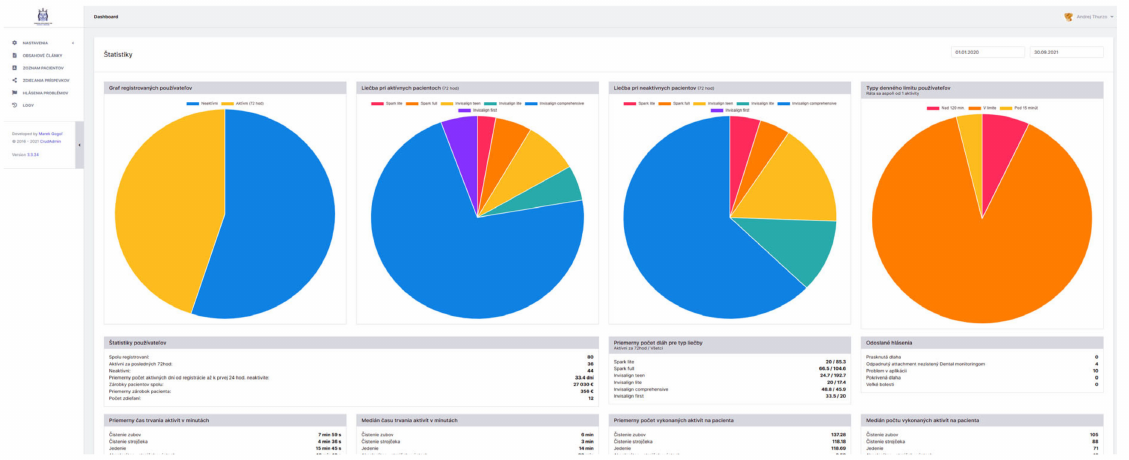
Figure 4. The view of the screen for administration. The portal of the server back-end for doctors and other administrators provides useful interface for statistical data processing and interactions with the system. Pie charts from left describe percentage of active users within the last 72 h (from all registered users), types of monitored appliances in the active users (Spark lite, Spark full, Invisalign teen, Invisalign lite, Invisalign comprehensive, Invisalign first), types of monitored appliances in the non-active users, types of daily limits of removed aligners (over 120 min, within 120 min limit and under 15 min). On the Figure bellow there are visualized user statistics, average times for various habits, Average time per aligner or frequency of patient